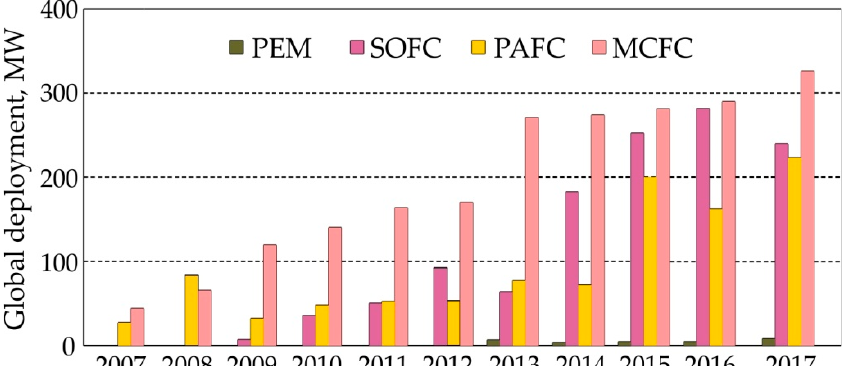
Figure 13. Global deployment of large-scale fuel cells, prepared on the basis of [143].